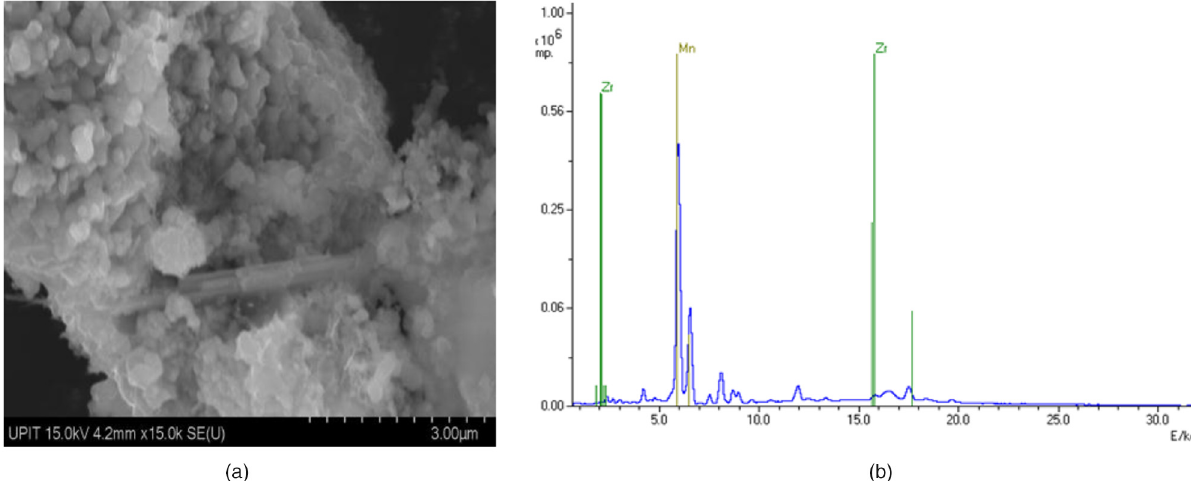
Fig. 5. (a) SEM micrograph of nano-SPVD powders of MnO doped with Zr. (b) EDX spectrum of nano-SPVD powders of MnO doped with Zr.